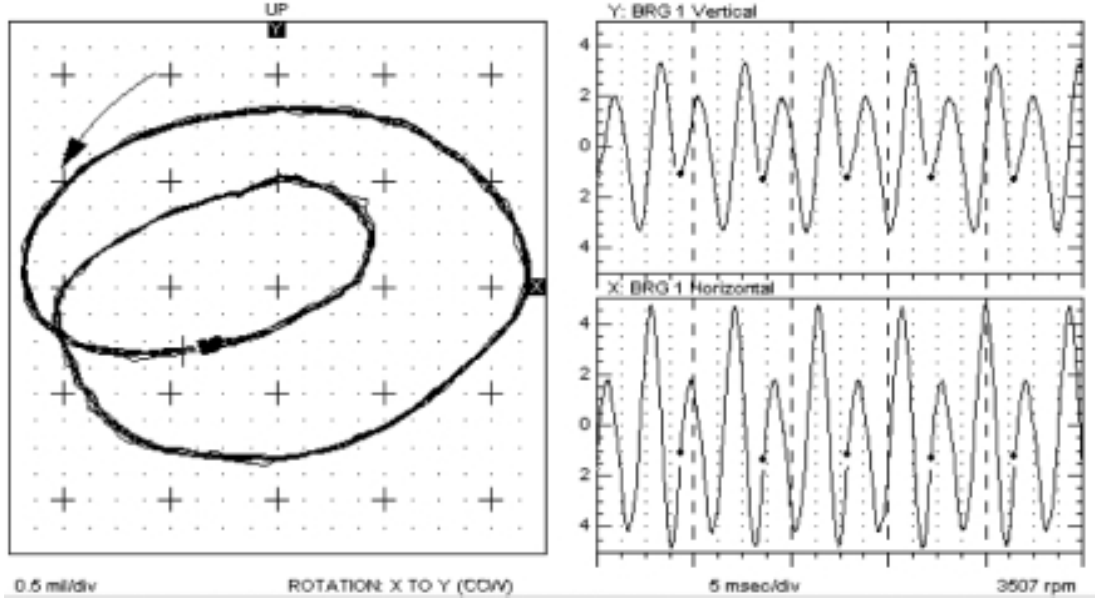
Fig. 9. Orbit of steady state data for the 1st shaft with 4 mm notch crack and 8 kg vertical hanging side load before the shaft